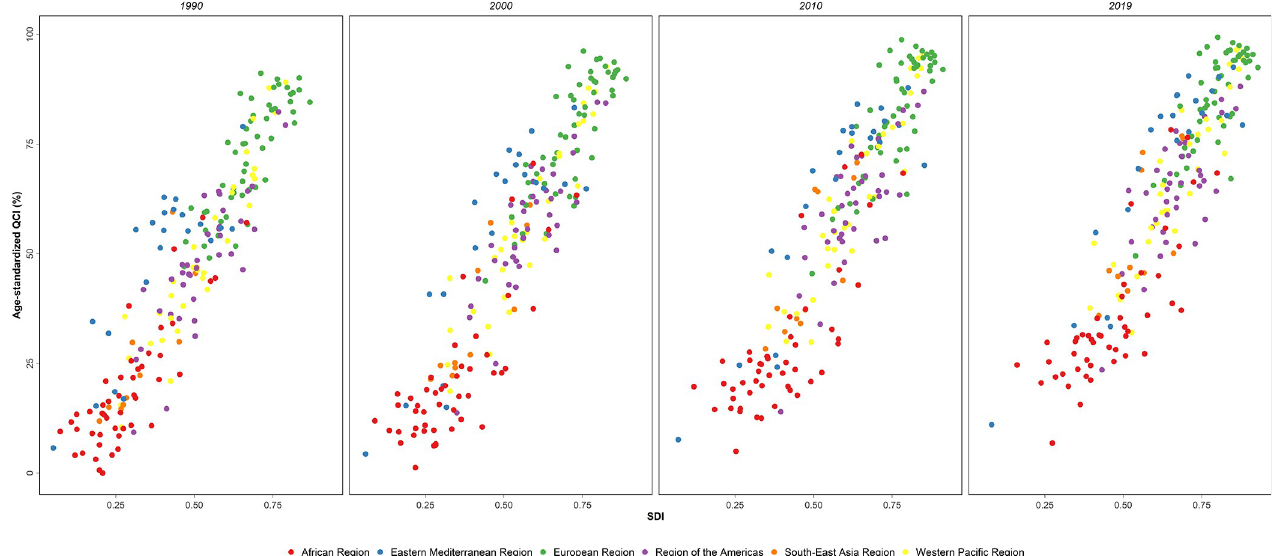
Fig 2. Scatter plot of age-standardized QCI (%) for the countries by the 6 WHO regions. Note that the following locations were not initially part of the WHO regions; however, we assigned them to the regions of their locations based on the GBD secretariat opinion. Bermuda, Greenland, and Puerto Rico were assigned to the region of the Americas; Guam, Northern Mariana islands, Taiwan, and Tokelau to the Western Pacific region; and Palestine to the Eastern Mediterranean region. https://doi.org/10.1371/journal.pone.0275574.g002 1990. The global trend resembles more the high and high-middle SDI countries. In 2019, QCI scores of high SDI, high-middle SDI, and overall SDI were above 75 for all the three presented age groups (15–49, 50–75, and 75+) and did not differ much. However, older patients had more remarkably lower SDI in the middle, low-middle, and low SDI countries.